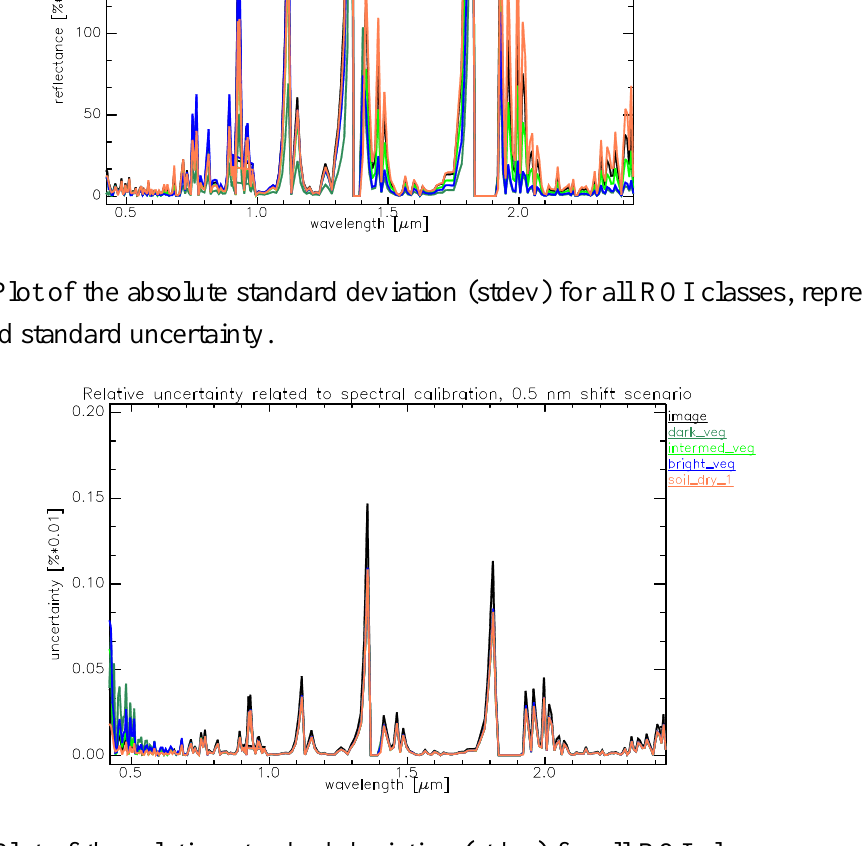
Figure 15. Plot of the relative standard deviation (stdev) for all ROI classes, representing the relative combined standard uncertainty of the 0.5 nm shift scenario.